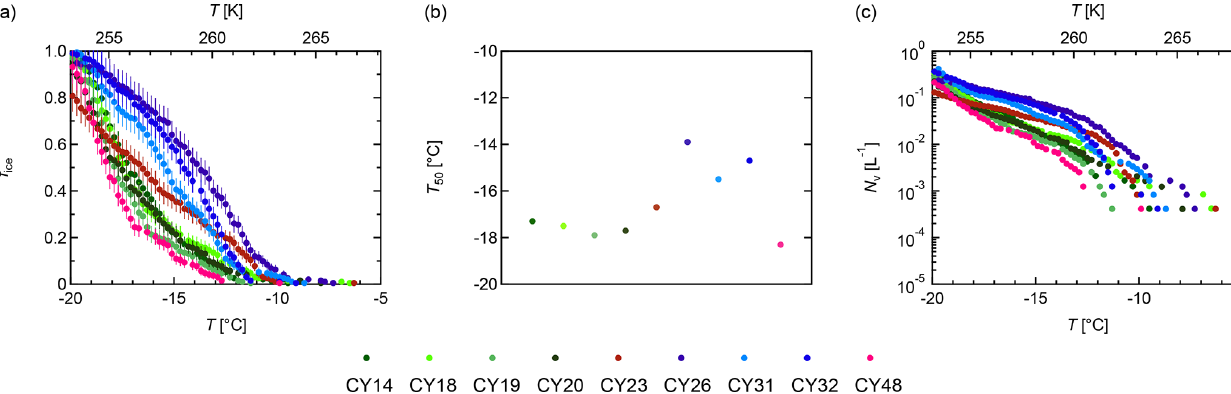
Figure 7. Ice nucleation activity. Fraction of frozen droplets ( f ice ) (a) and cumulative number of IN ( N v ) per liter of air (b) vs. temperature ( T ) for all aerosol samples. The colors represent individual samples; the error bars were calculated using the counting error and the Gaussian error